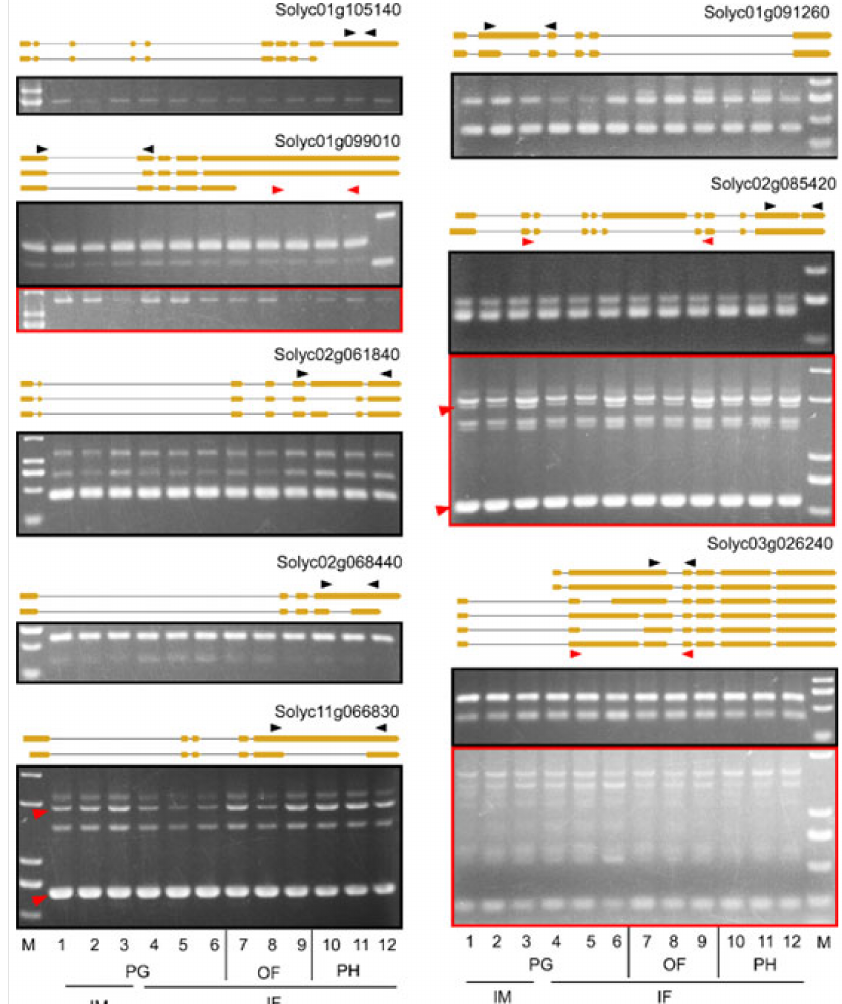
Figure 3. RT-PCR verification of several major splice variants identified by RNA-seq. AS events predicted in ten DAGs were selected for RT-PCR verification. The figure shows splice variants successfully verified in eight DAGs. The positions of primers to specifically amplify regions having AS events were indicated by arrowheads either above or beneath the gene models. Gel images boxed in black and red showed RT-PCR amplifications using primers indicated by the same colors. Sample loading sequence: LA1589 (1, 4, 7, 10); LA1781 (2, 5, 8, 11); LA2706 (3, 6, 9, 12). M, DNA size